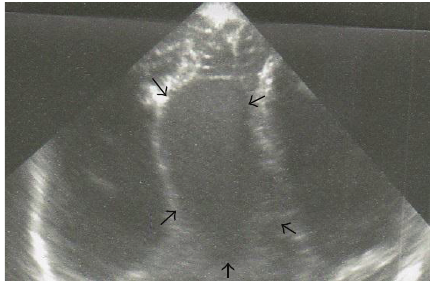
Figure 1: Ultrasound imaging of our case’s aneurysm of vein of Galen.